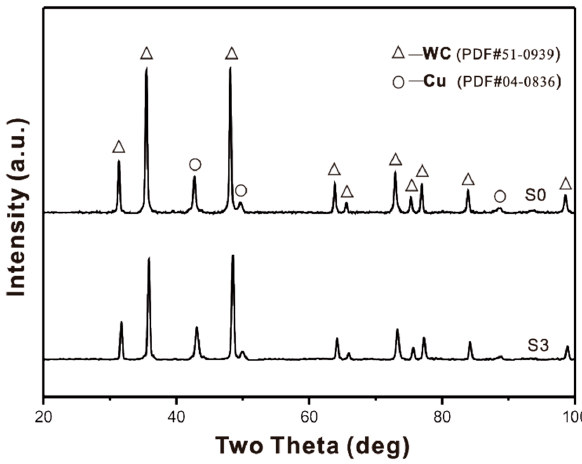
Figure 2. XRD patterns of samples S0 and S3.